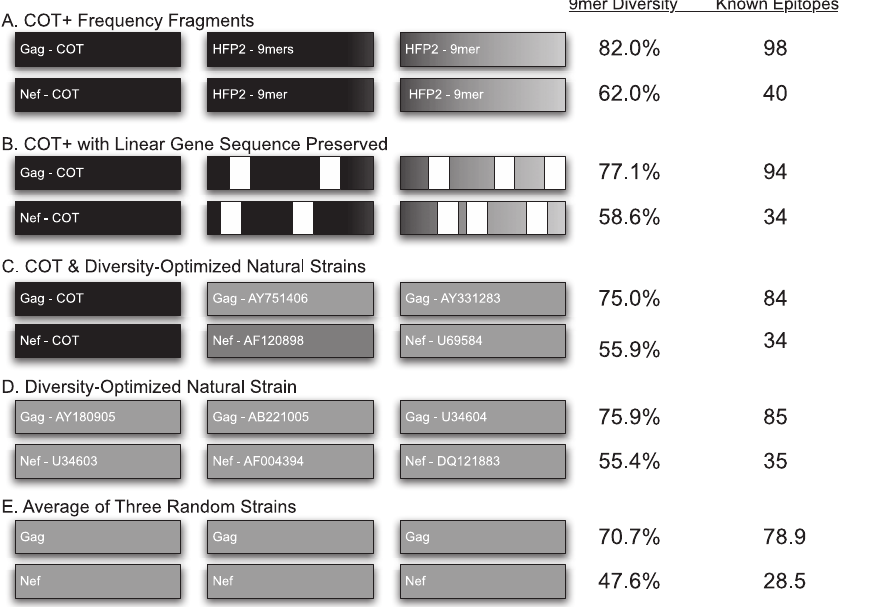
Figure 5. Possible Configurations for Vaccine Constructs Each bar represents one unit-length gene. The fill intensity of each bar represents the density of unique peptides and known CTL epitopes. The coverage that each construct captures of the amino acid diversity of the dataset is shown on the right for both 9mers and epitopes. (A) COT þ , composed of the estimated COT plus the appended high-frequency peptides (HFPs) composing the second and third gene lengths. (B) COT plus HFPs placed into a gene collinear fashion on the second and third gene lengths. (C) COT plus two NSs chosen to maximize 9mer coverage. (D) All NSs of Gag and Nef sequences chosen such that 9mer coverage is maximized and for comparative reasons (E) is average coverage across all NSs. The GenBank IDs of the NSs are written inside each bar.